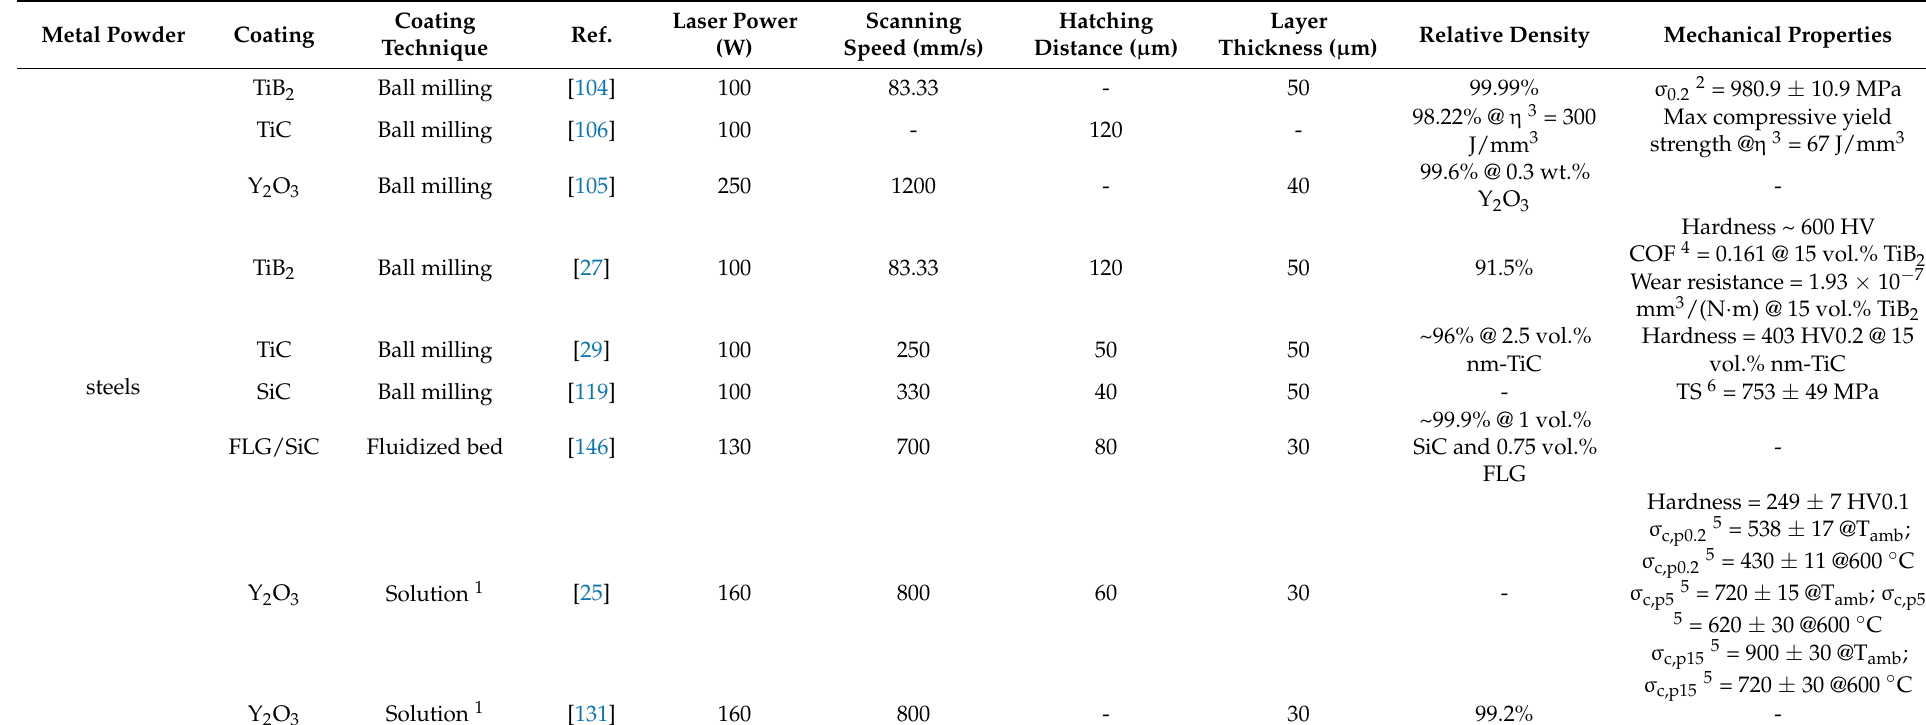
Table 2. A summary table reporting L-PBF process parameters, relative density and mechanical properties of printed parts using Fe-based